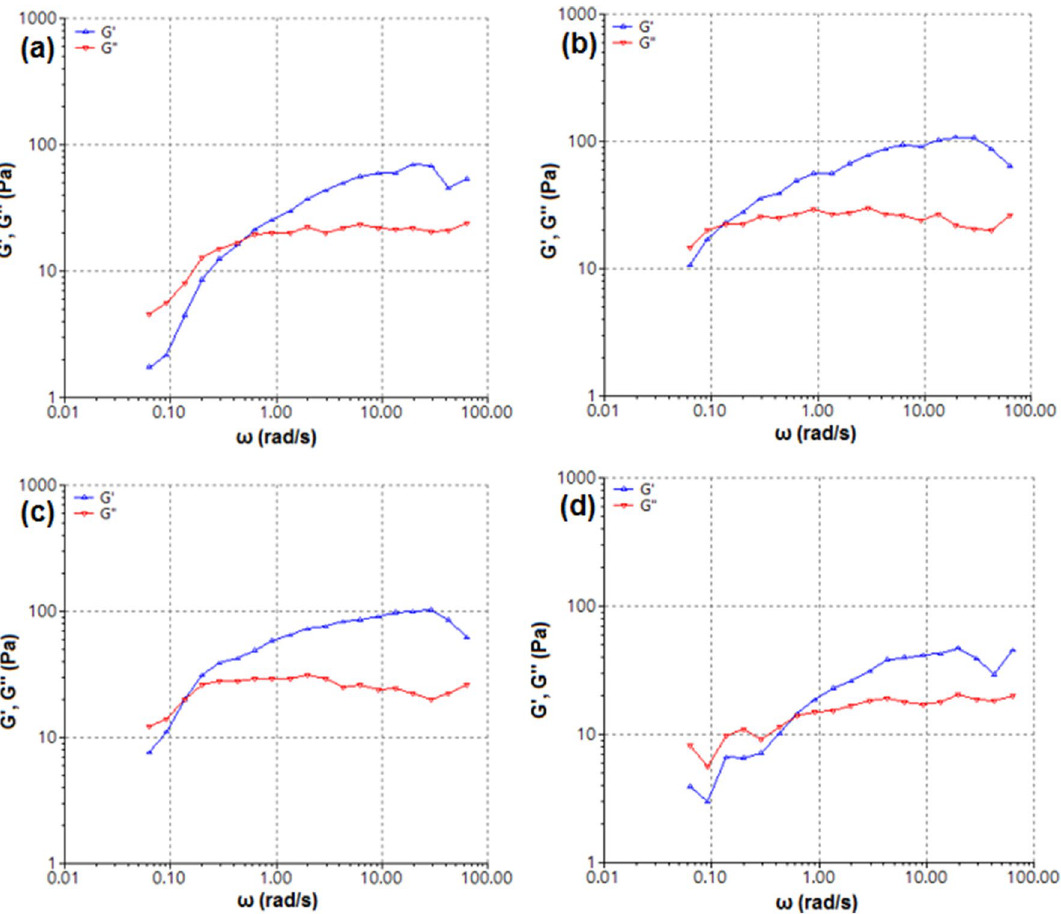
Figure 8. Oscillation frequency sweep (@2.0 Pa) rheograms depicting G ′ , G ″ versus angular frequency for ( a ) CHT; ( b ) CHT-mPEG; ( c ) CHT-mPEG-CHO; and ( d ) CHT-mPEG-COOH blend solutions.